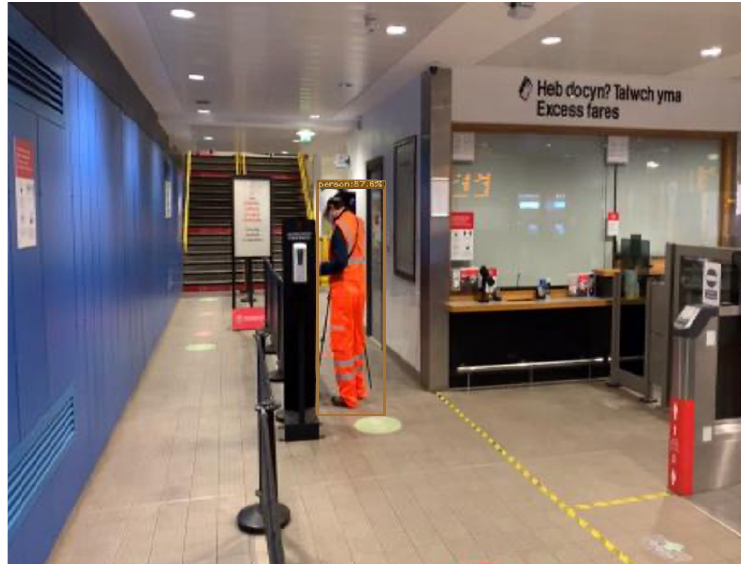
Figure 7. Object detection results of YOLOX on custom